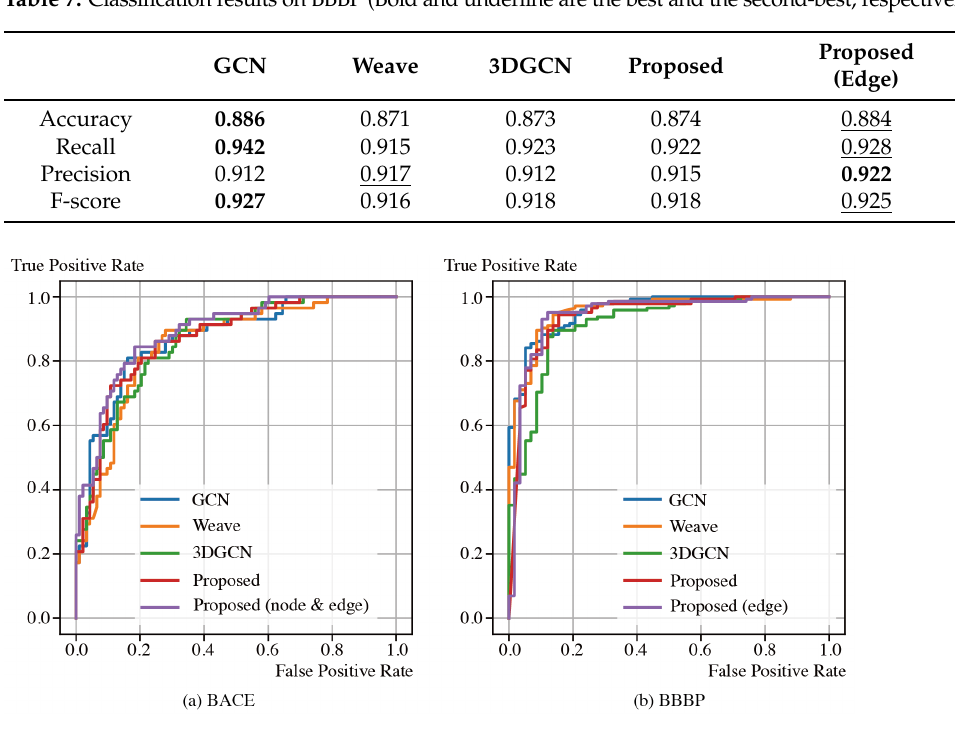
Table 7. Classification results on BBBP (Bold and underline are the best and the second-best, respectively).